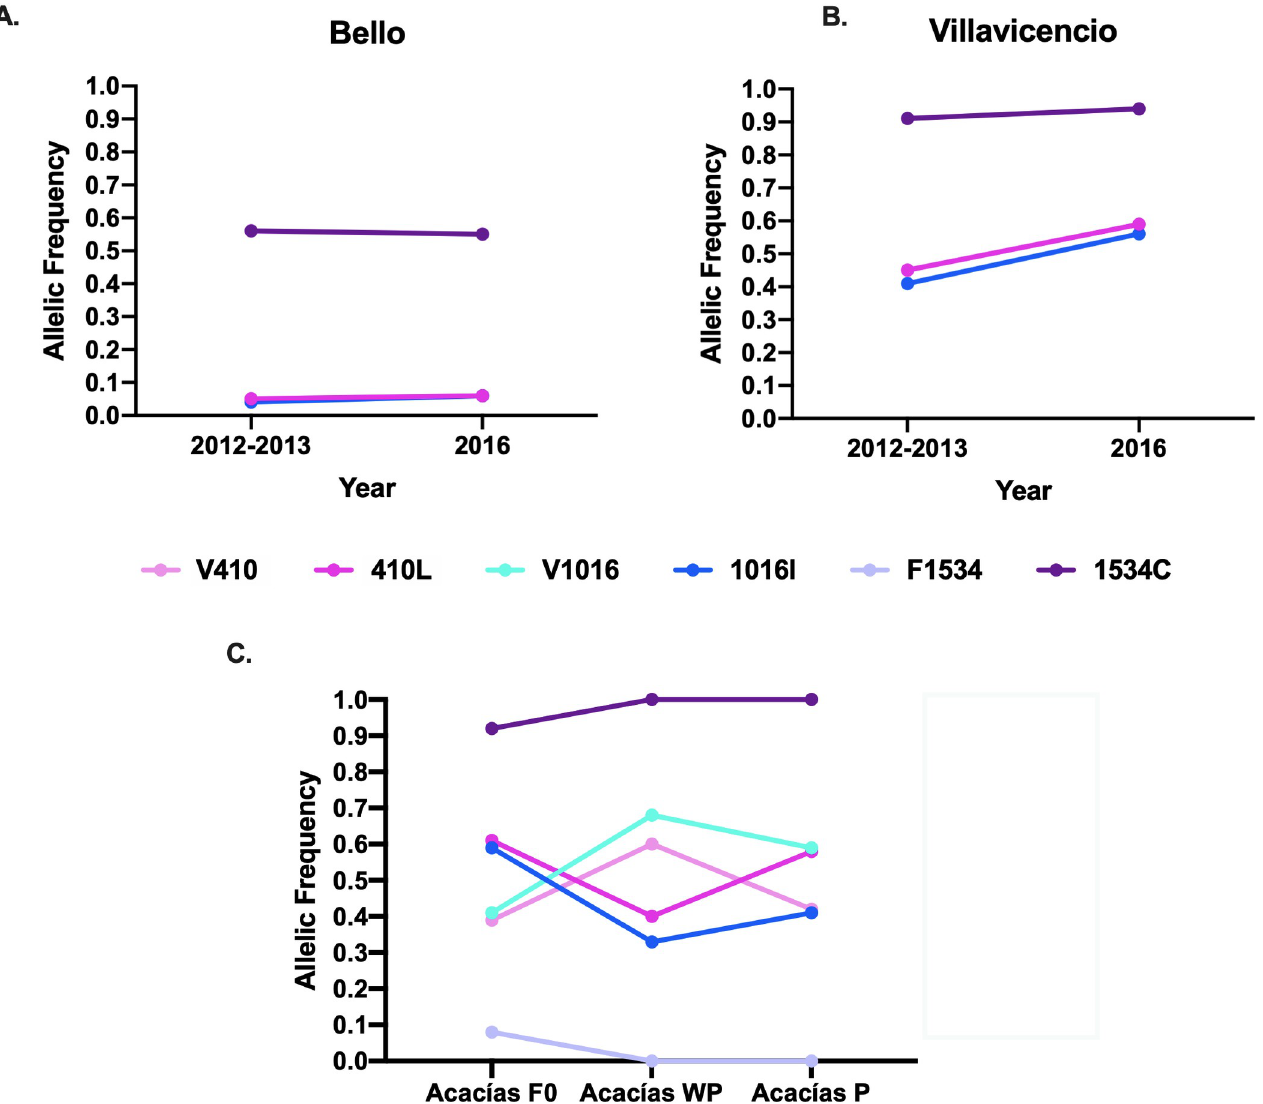
Fig 3. Allelic frequencies for the positions V410L (pink), V1016I (blue), and F1534C (purple) in Aedes aegypti from three of the mosquito populations studied. The light colors indicate the wt allele frequencies; the dark colors show the mutated allele frequencies. A-B . Time-course of allelic frequencies from Bello 2012–2013 (410 N = 58, 1016 N = 101, 1534 N = 57) and 2016 (410 N = 55, 1016 N = 59, 1534 N = 60) (A), and Villavicencio 2012 (410 N = 79, 1016 N = 89, 1534 N = 57 and 2016 (410 N = 50, 1016 N = 51, 1534 N = 51) (B) populations determined for mosquitoes collected in two different years. C. Allelic frequencies from Acacı´as population without lambda-cyhalothrin pressure (WP) and with lambda-cyhalothrin pressure (P) for six generations compared with the field-collected populations (Acacı´as